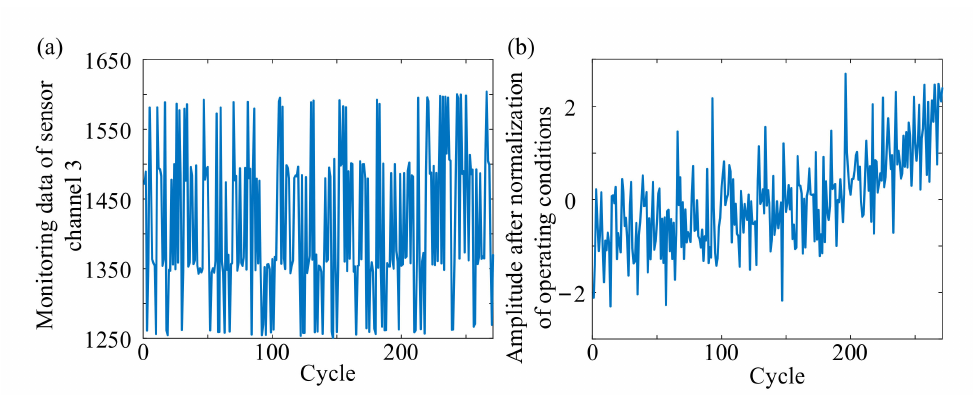
Figure 4. The simulation data of turbofan engine. ( a ) Monitoring data of Sensor Channel 3. ( b ) Data after normalization of operating